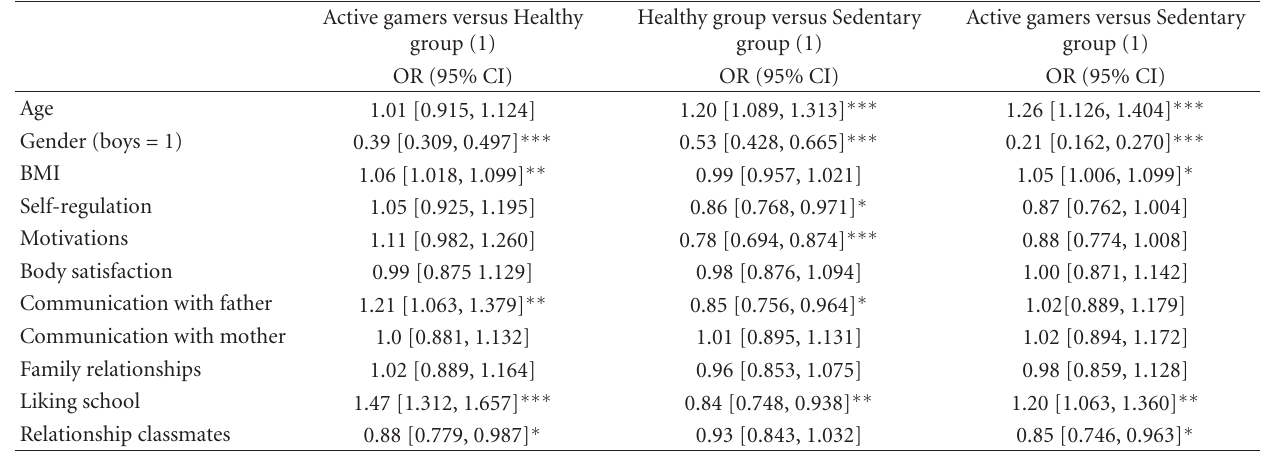
Table 3: Psychosocial predictors of each pair of